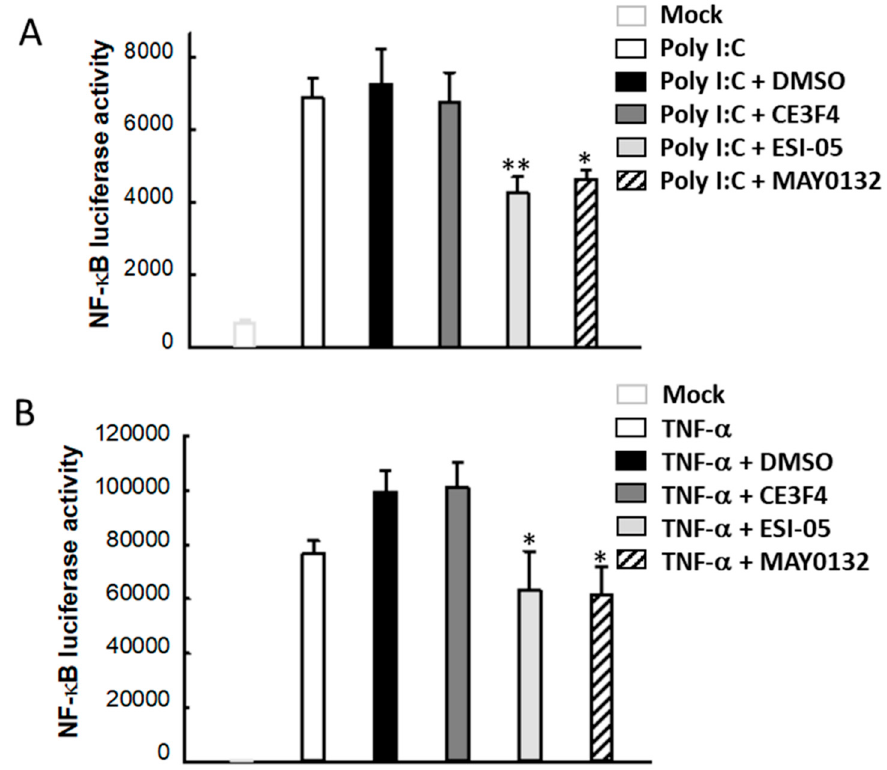
Figure 6. The EPAC2-mediated NF- κ B activation by poly I:C or TNF- α . ( A , B ) 293 cells in triplicate were transiently transfected with a luciferase reporter plasmid containing the NF- κ B promoter (NF- κ B-luc) in the presence of the indicated drugs. At 15 h post-transfection, cells were transfected with 1 μ g/mL poly I:C ( A ) or treated with 10 ng/mL of TNF- α ( B ) for an additional 6 h. Cells were then lysed to measure luciferase activities. Cells without poly I:C or TNF- α treatment were used as a negative control. Data are representative of three independent experiments. * p < 0.05 and ** p < 0.01, relative to the poly I:C-transfected and DMSO-treated group or the TNF- α - and DMSO-treated group,